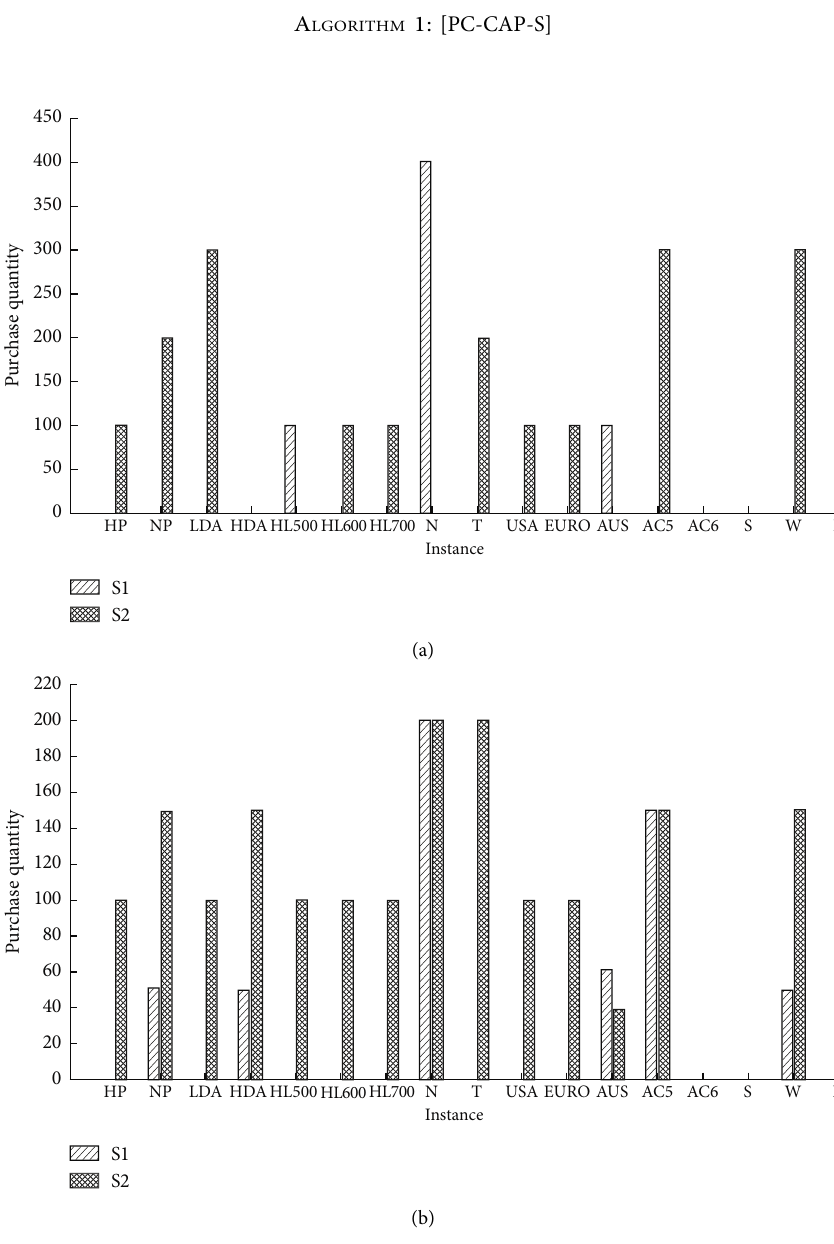
Figure 8: Configuration results under both purchasing strategies: (a) purchase amount based on single-sourcing; (b) purchase amount based on